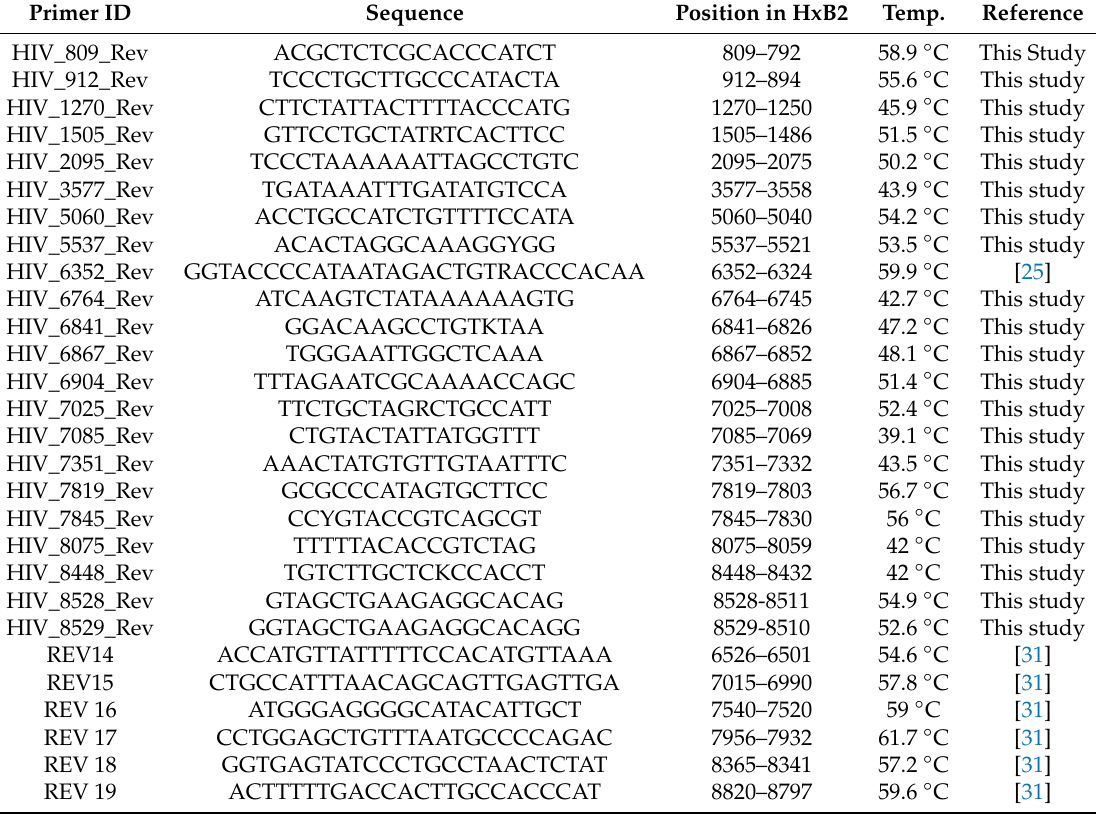
Table 3. Reverse Sequencing